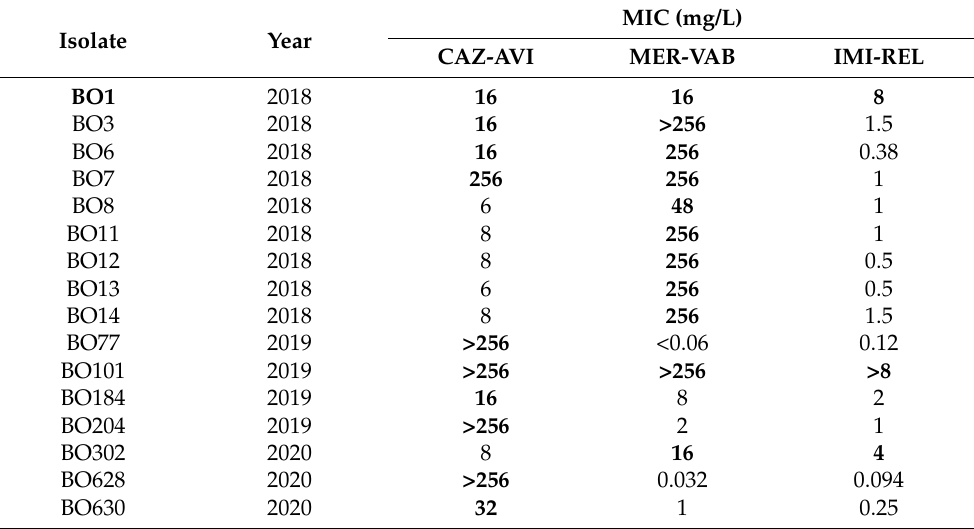
Table 2. Phenotypic characteristics of KPC-Kp strains included in this study.